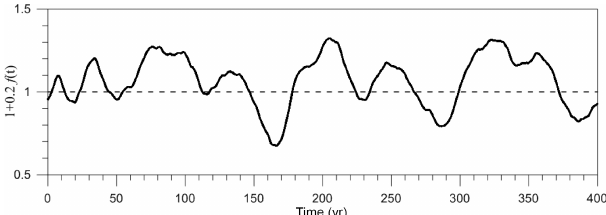
Figure 17. Aperiodic forcing G(t)/γ of the idealized ocean model – defined by Eq. (11) herein, and plotted using the value ε (cid:48) = 0 . 2, as adopted in Pierini et al.